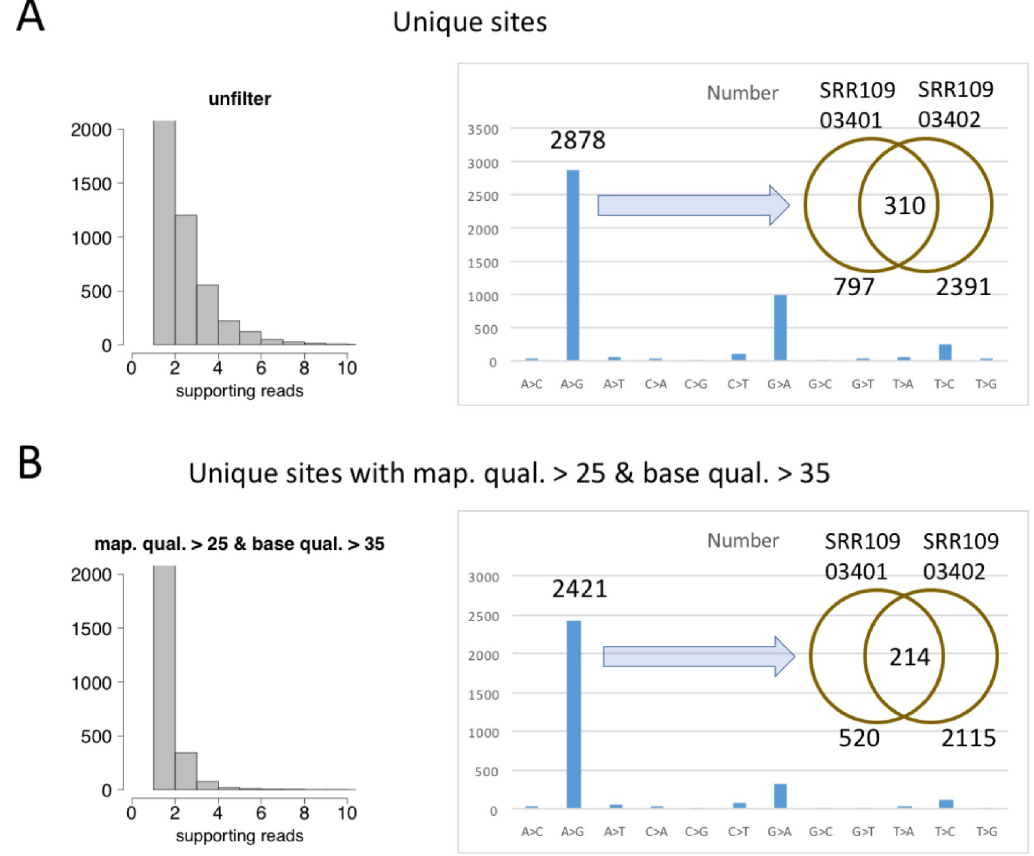
Fig 4. The numbers of unique mutation sites. (A) Distribution of reads count supporting each variation site and the numbers of different mutation types. This is the unfiltered results. (A) Distribution of reads count supporting each variation site and the numbers of different mutation types. This is the results with mapping quality > 25 and base quality >